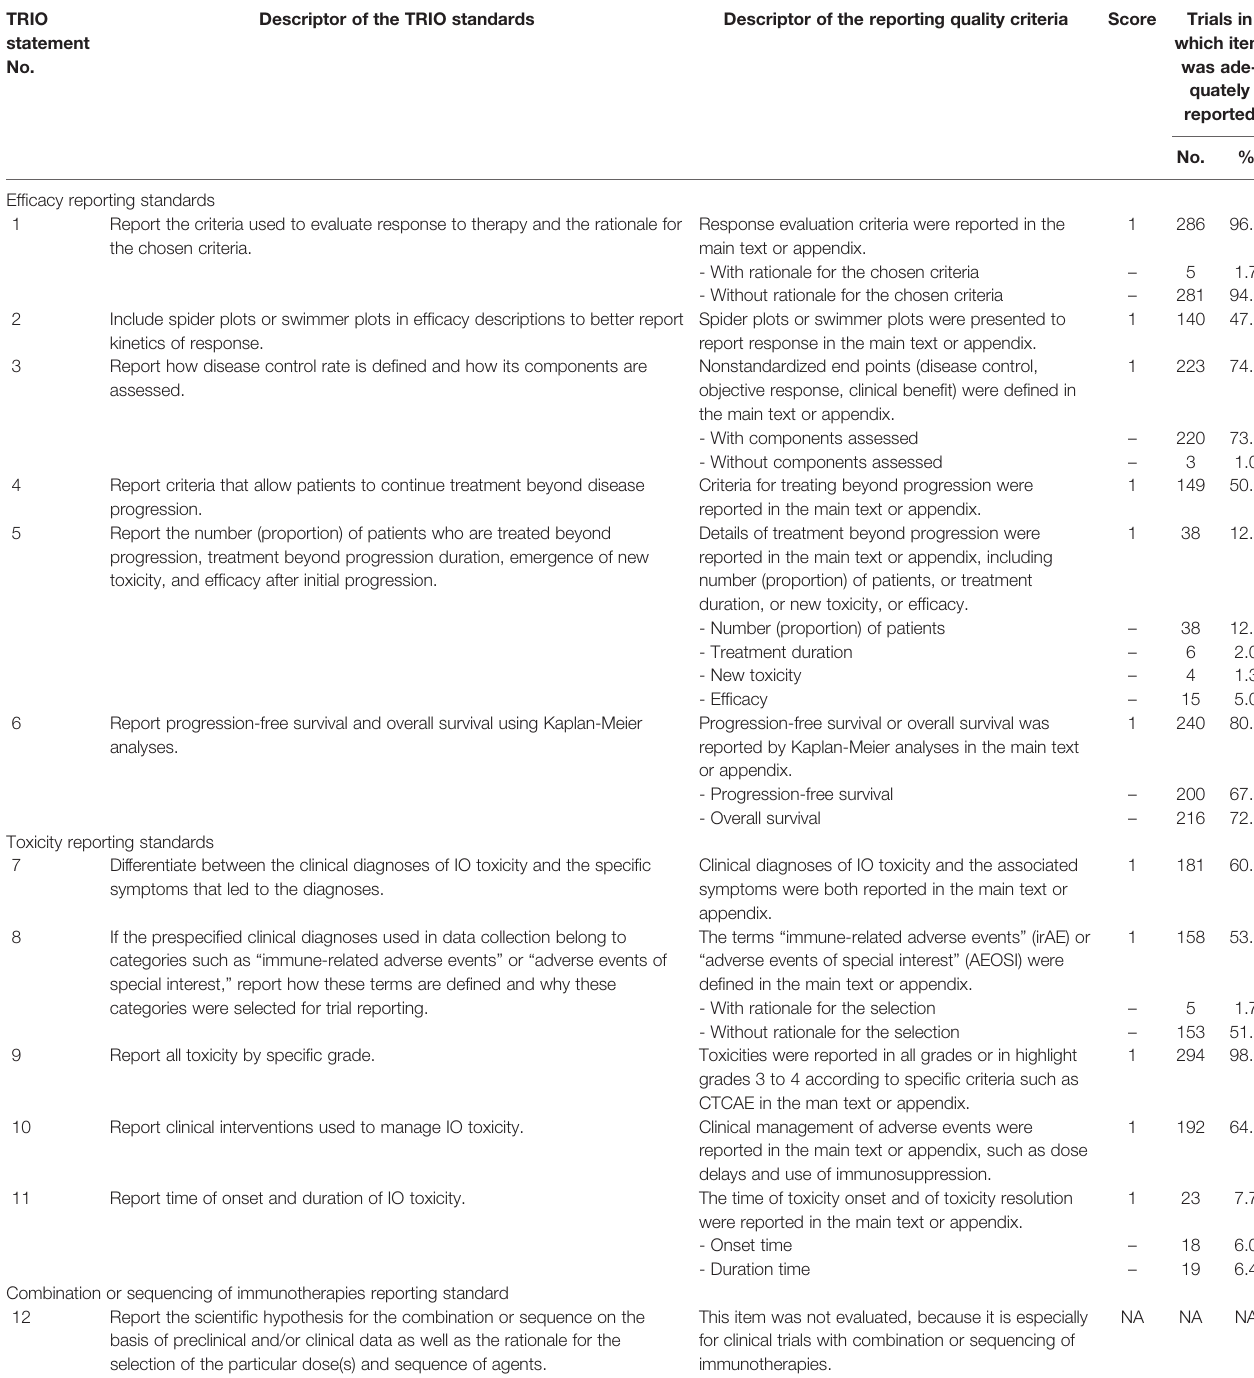
TABLE 1 | Quality of immune-oncology clinical trial reporting using items from the Trial Reporting in Immuno-Oncology (TRIO)